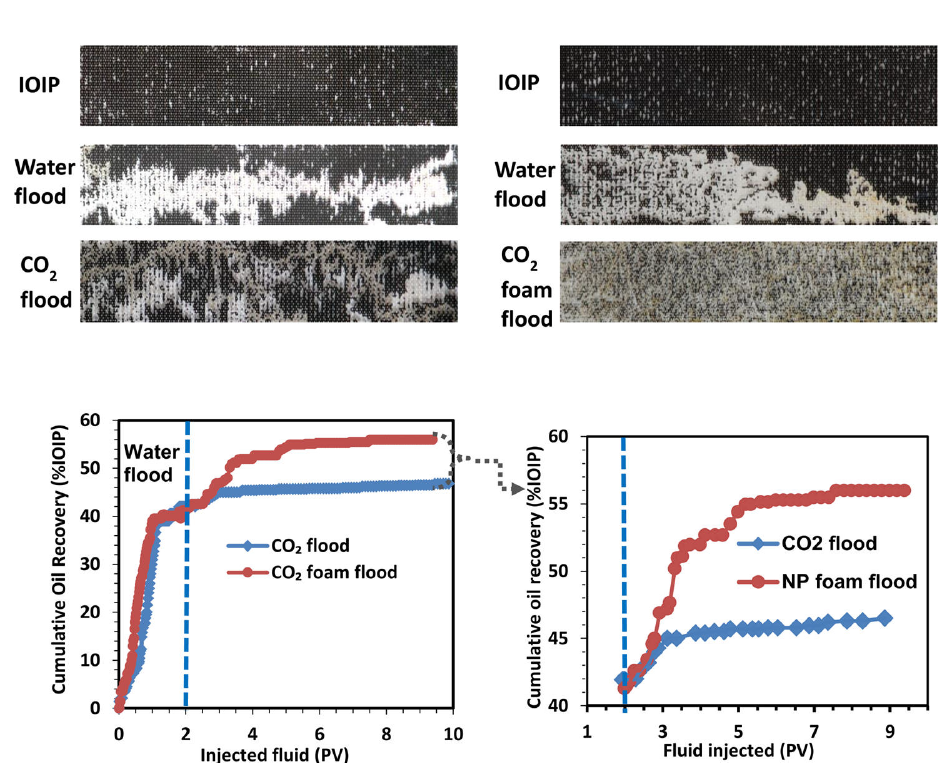
Figure 25. Comparison of the oil recovery after a waterflooding with CO 2 vs. nanoparticle–CO 2 foams. Images of initial oil in place (IOIP), secondary recovery, and CO 2 flood ( top left ); nanoparticle-stabilized CO 2 foam flooding ( top right ); cumulative oil recovery ( bottom left ); and an enlarged plot of the recovery after the waterflooding ( bottom right ). Figure reproduced from Ref.